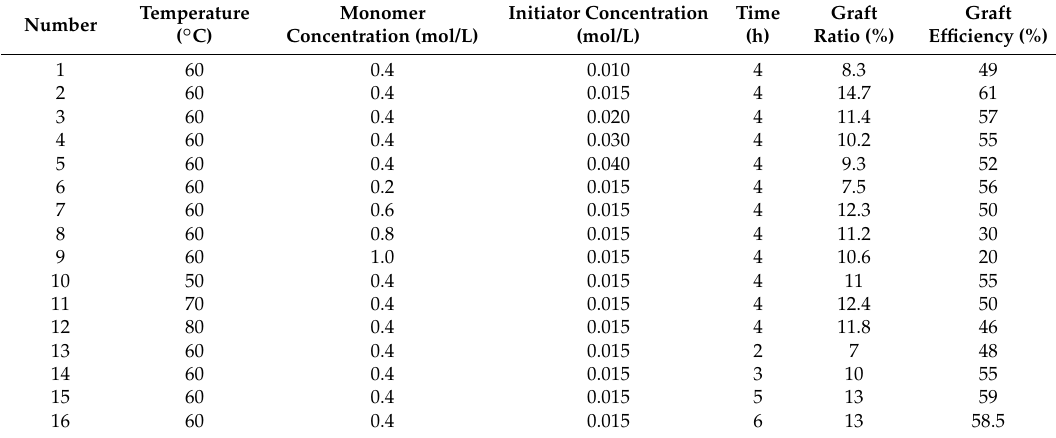
Table 1. Synthesis conditions of xylan grafted with